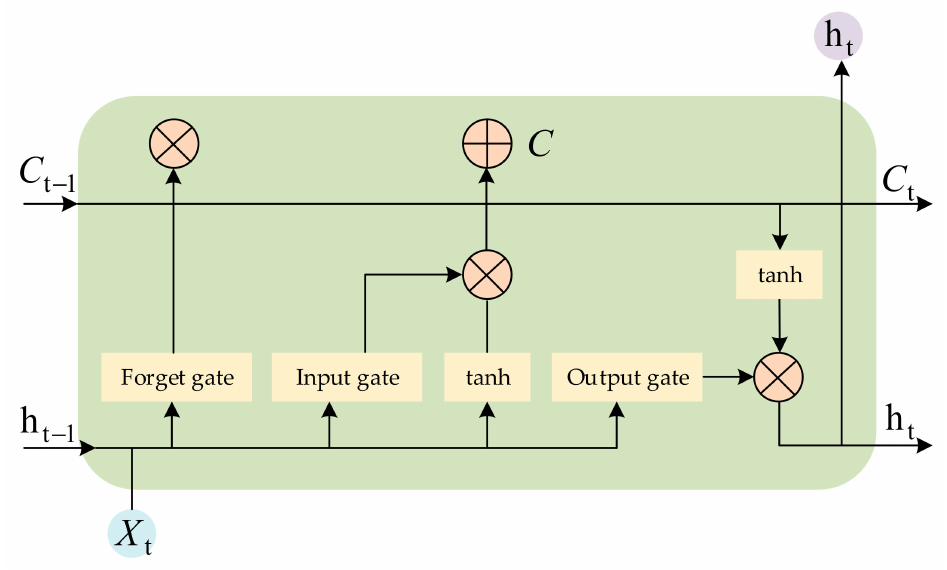
Figure 5. The core unit of the